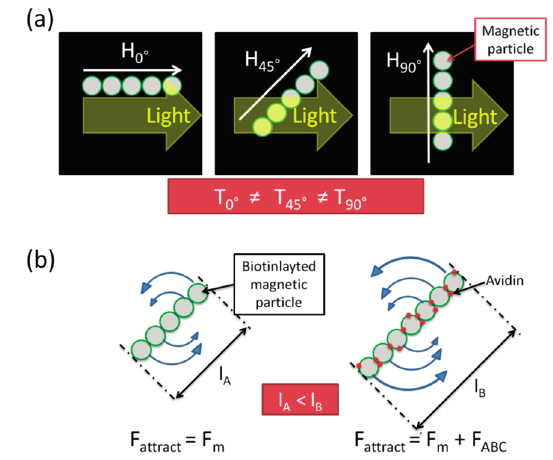
Figure 14. ( a ) schematic image of the chain-shape nano-sized particles by rotating magnetic field. Transmitting light has a dependence of the angle between the direction of the chain and the path of the light; ( b ) length dependence of the biotinlayted nano-sized magnetic particles in rotating magnetic field with and without avidin. Because avidin interconnects biotin, the force between the particles is the sum of the magnetic interaction and the biological conjugation force via avidin–biotin interaction resulting in the increase of the chain length. Adapted from